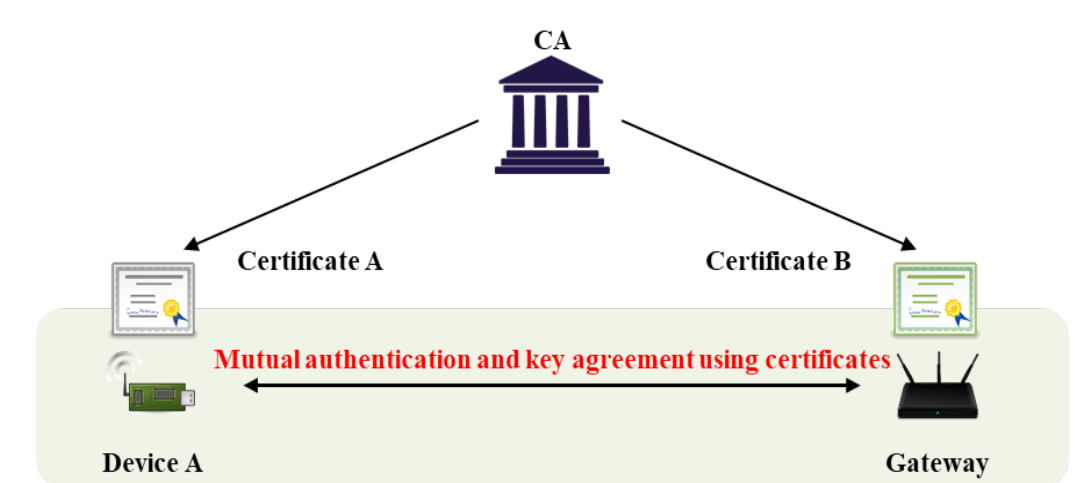
Figure 2. Mutual authentication flow with gateway.